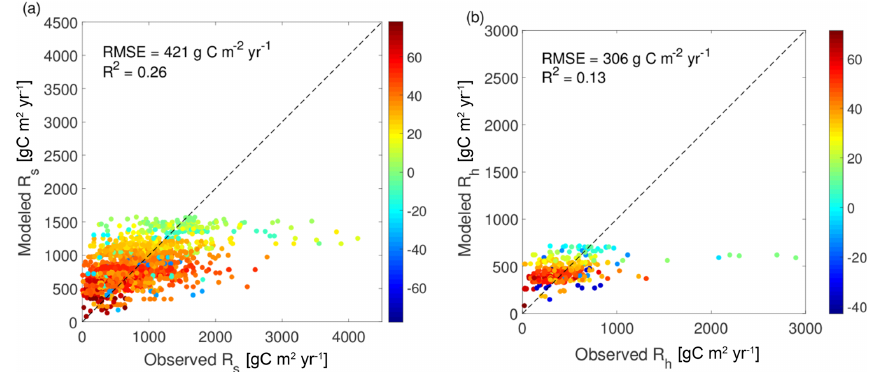
Figure 6. Comparison of observed annual respiration terms at SRDB sites vs. bottom-up estimates at the same sites for (a) 1979 soil respiration sites and (b) 362 heterotrophic respiration sites. Each point denotes a single experiment and is colored by the experiment’s latitude.